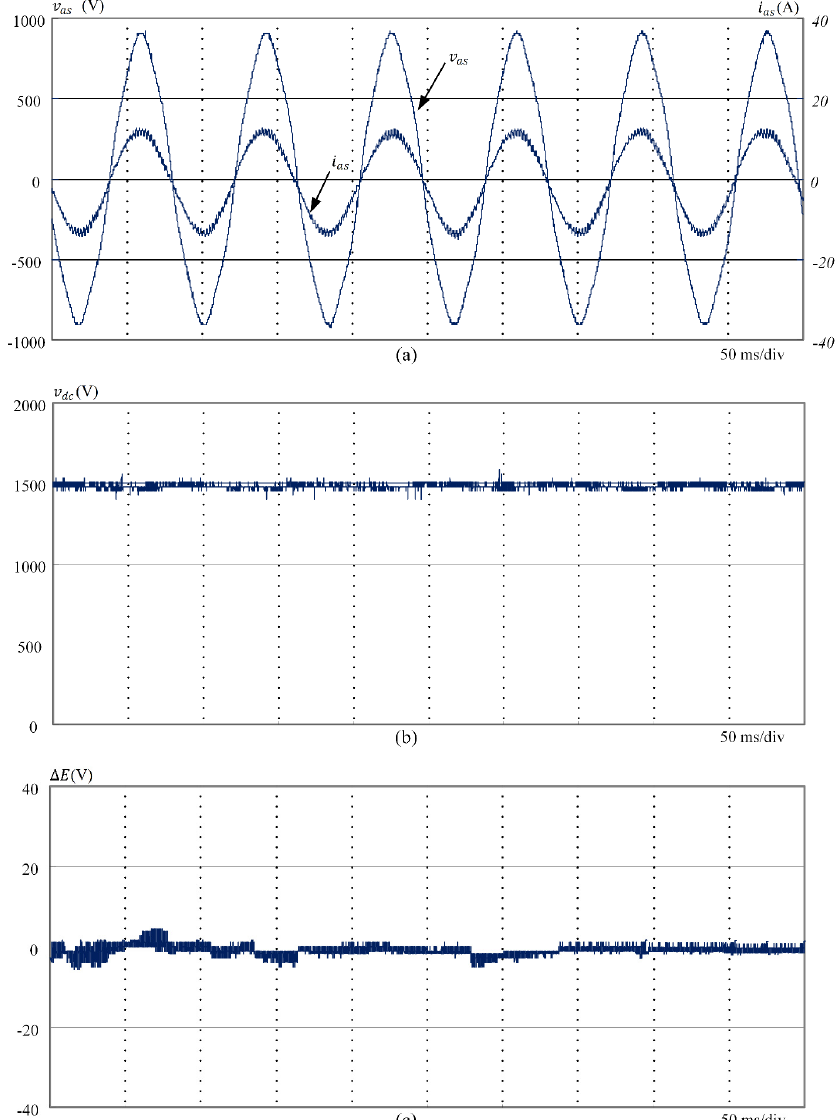
Figure 13. Experimental results of the proposed system for resistive loads (cid:1844) 20 Ω : ( a ) generator phase-voltage (cid:1874) voltage error between the upper and the lower